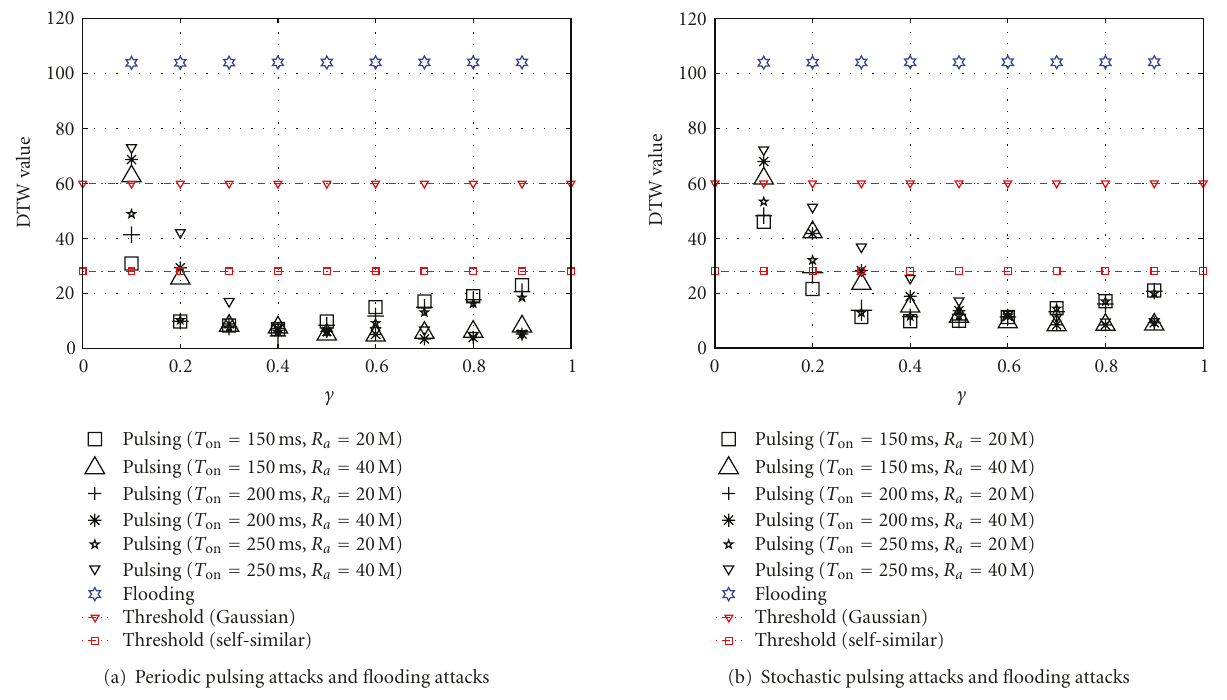
Figure 9: Average detection time for pulsing and flooding attacks using the DTW method.